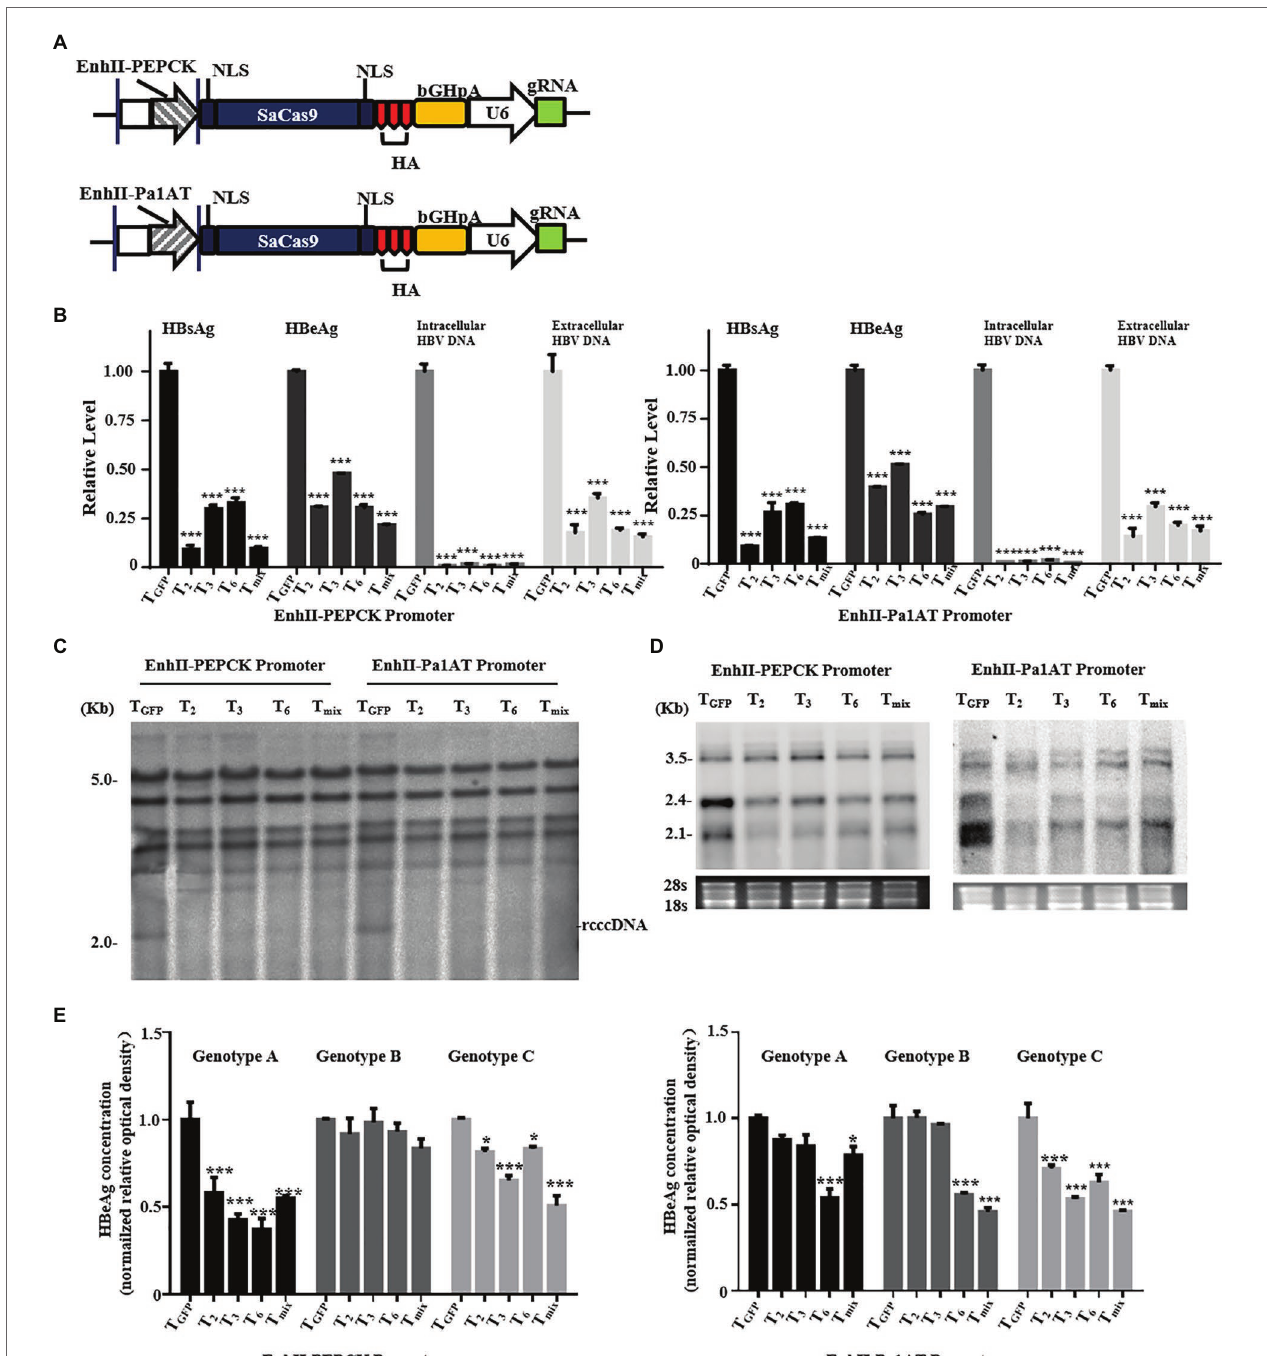
FIGURE 4 | Anti-HBV effects of the CRISPR/SaCas9 system under the control of the chimeric liver-specific promoter in Huh7 cells. Huh7 cells were co-transfected with reconstructed gRNA/SaCas9 system plasmids and reproduce rcccDNA system plasmids. (A) Design of the reconstructed gRNA/SaCas9-expressing vector pX601-U6- HBVgRNA plasmids replaced with a chimeric liver-specific promoter. NLS, nuclear localization signal; HA, HA-tag; SaCas9, human codon-optimized S. aureus Cas9; bGHpA, bovine growth hormone poly(A) signal. (B) At 48 h post-transfection, HBsAg and HBeAg were measured using ELISA. The intracellular HBV replication intermediates and extracellular virion DNA were measured using qPCR at 96 h post-transfection. (C) At 48 h post-transfection, measurement of the HBV intracellular replication was through Southern blotting. (D) At 48 h post-transfection, measurement of the HBV RNA transcripts was by Northern blotting. (E) The genotype A, B, and C HBV replicons were co-transfected with the reconstructed gRNA/SaCas9 system plasmids. At 48 h post-transfection, the relative levels of HBeAg were measured using ELISA. In each of the transfections, the pSV- β -gal plasmid was included to normalize the transfection efficiencies. The results of ELISA and qPCR were calculated from three independent experiments and the data are presented as the mean ± SEM. * p < 0.05 and *** p < 0.001. T mix , the mixture of T 2 , T 3, and T 6